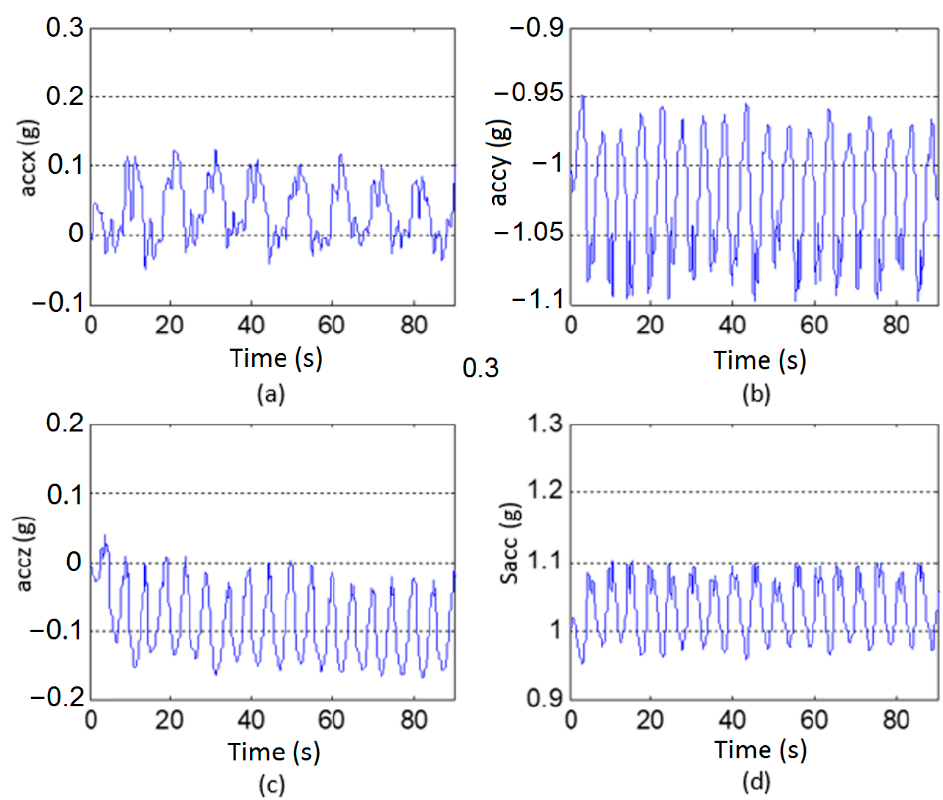
Figure 3. Acceleration data of D01: ( a ) x axis acceleration; ( b ) y axis acceleration; ( c ) z axis acceleration; ( d ) Sacc superposition acceleration.